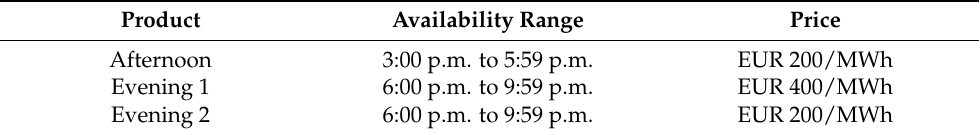
Table 1. UVAM availability